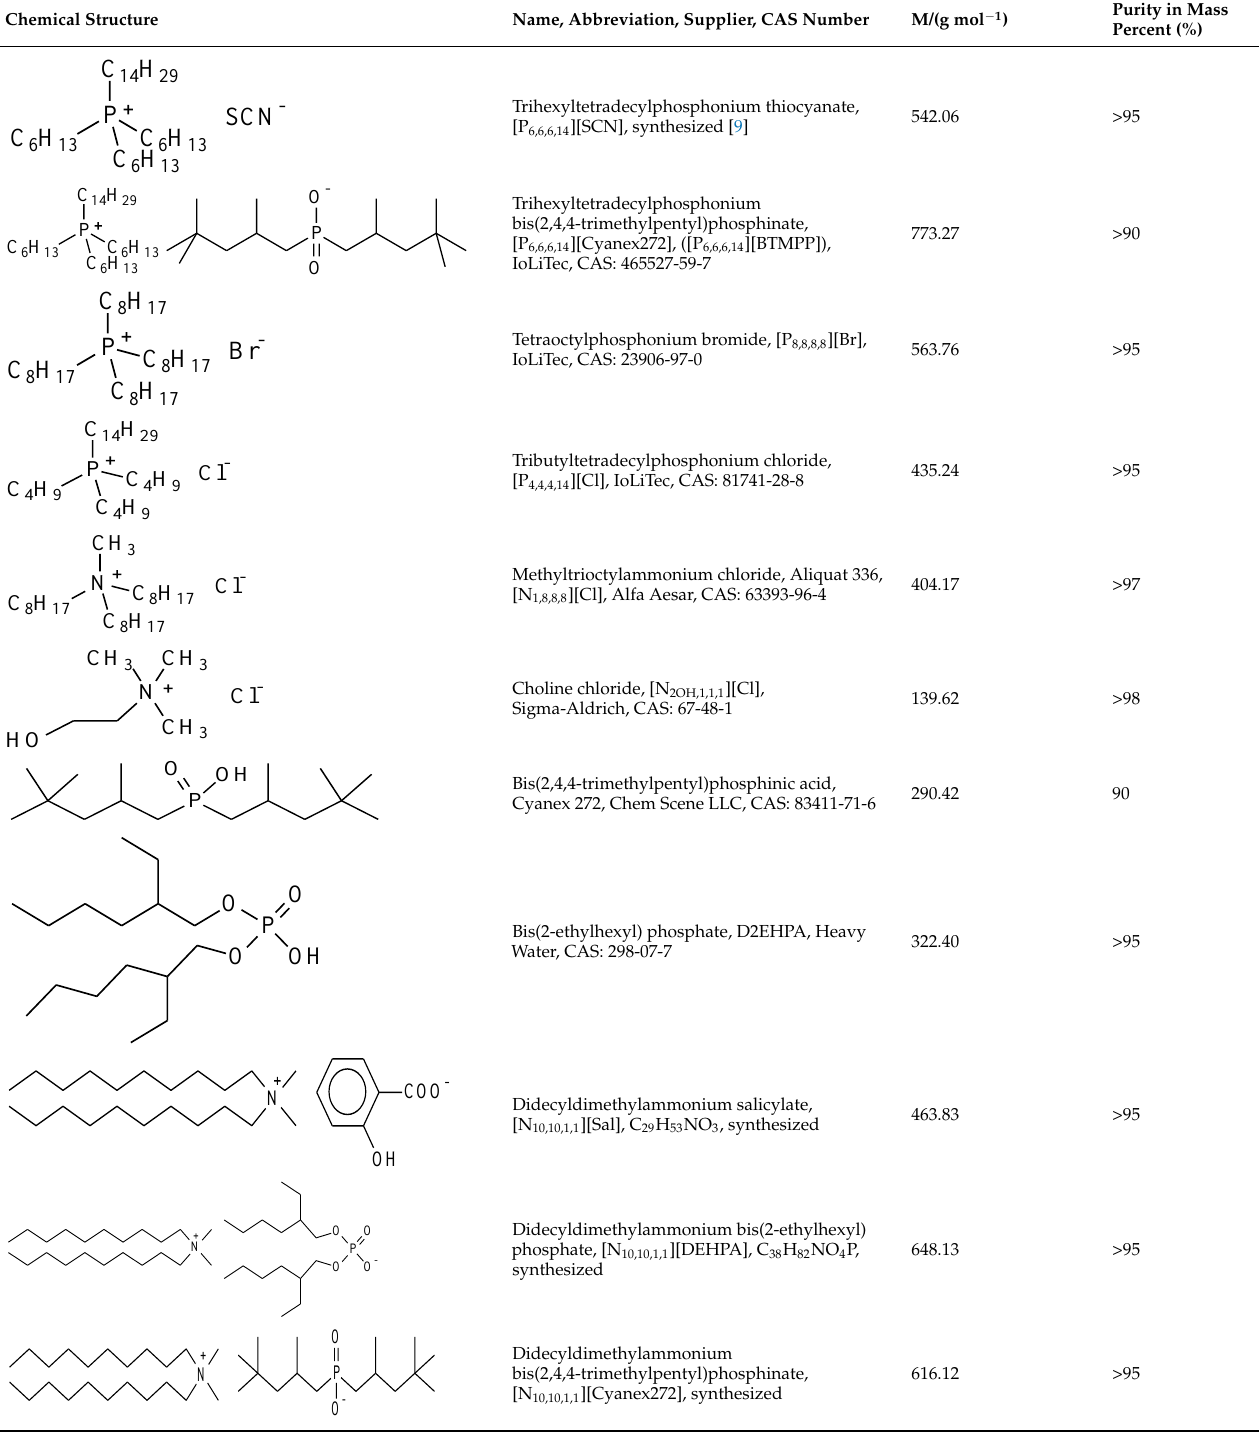
Table 6. Data on the chemicals used: name, supplier, CAS number, molecular mass (M), mass frac- tion purity (as stated by the supplier).